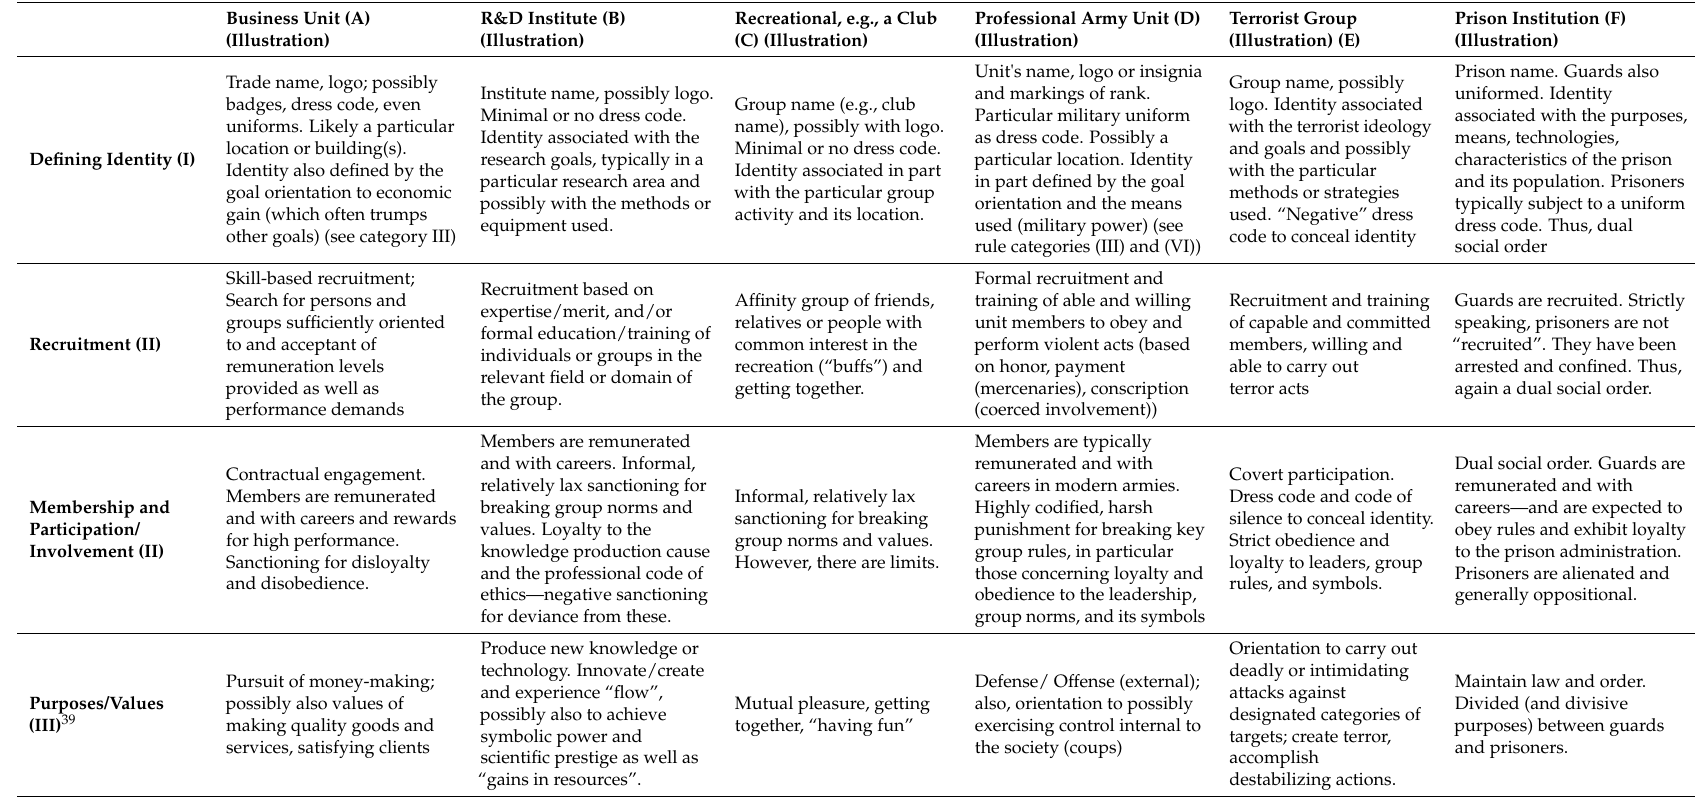
Table 3. Illustrations of Group Rule